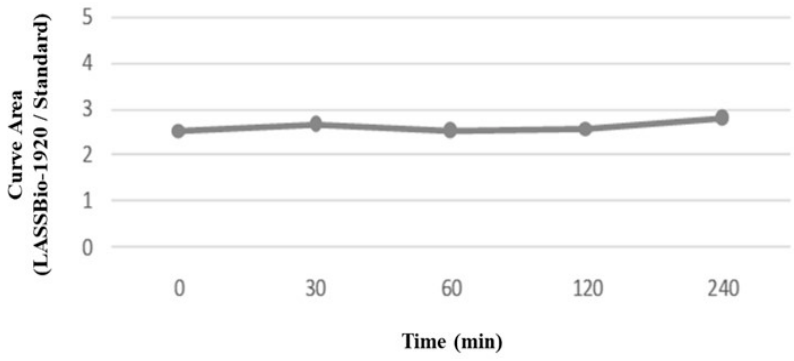
Figure 9. Plasma stability of LASSBio-1920 and the standard methyl biphenyl-4-carboxylate.